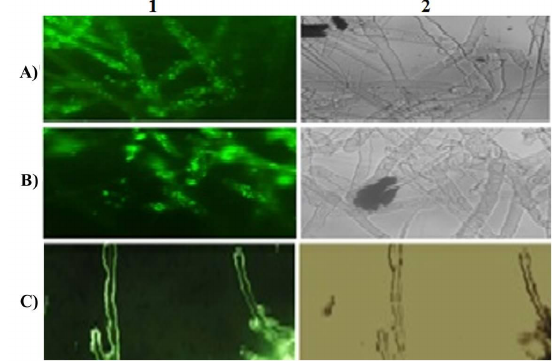
Fig. 6. Fluorescence microscopy of fungal cells in presence of SYTOX Green: R. solani cells were supplemented with 5mM MgCl2 and SYTOX green and treated for 6 h in the presence or absence of the purified protein (5µg); Right panels are light microscopic and left panels are fluorescence microscopic images; (A and B) Presence of 5µg purified protein for 6 h; (C) empty vector protein as a negative